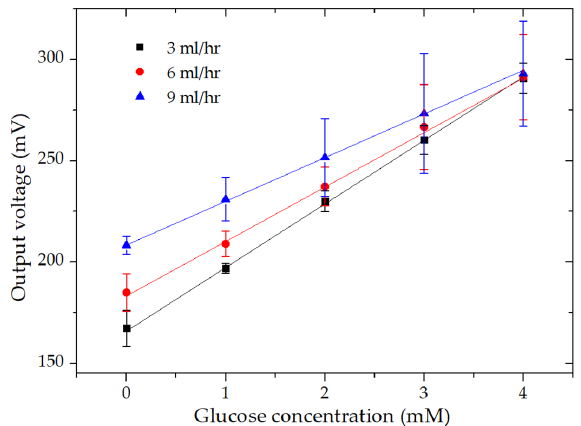
Figure 5. Linearity curves of the output voltage of the microfluidic EBFC at a current density of 100 µA.cm −2 plotted at the flow rates of 3, 6, and 9 mL/h as a function of glucose concentration.